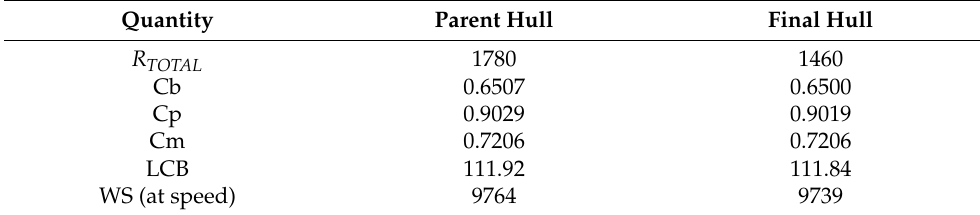
Figure 14. Comparison of optimized (red) and original hull stations. Table 6. Comparison of the parent and final optimized hull.